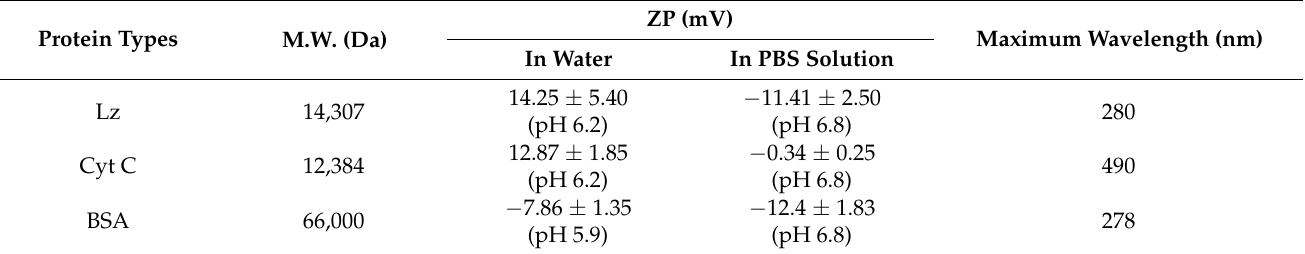
Table 1. Properties of the protein solutions in water or PBS, and the maximum UV wavelength for each